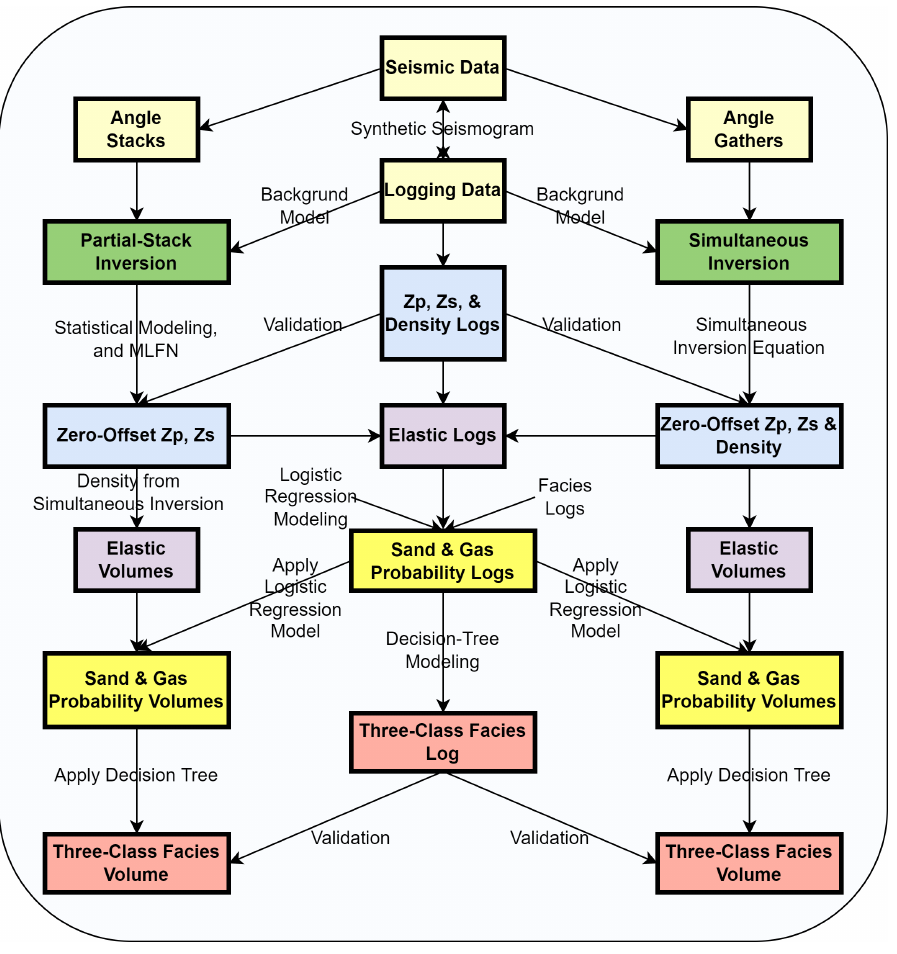
Figure 2. A flow diagram showing the methodology of estimating the facies distribution from the zero-offset acoustic and shear impedances, which are obtained from isotropic inversion, statistical modeling, and